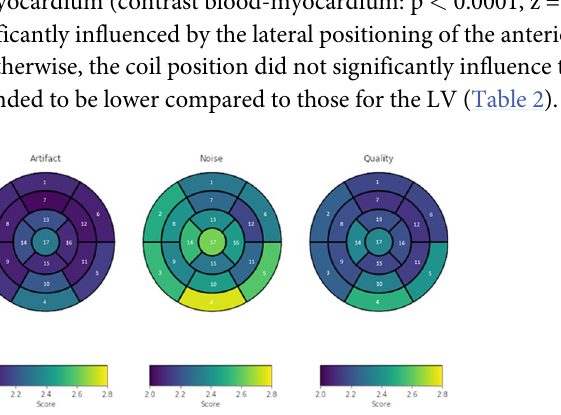
Given are the average values and in brackets the minimum, maximum and median are listed.